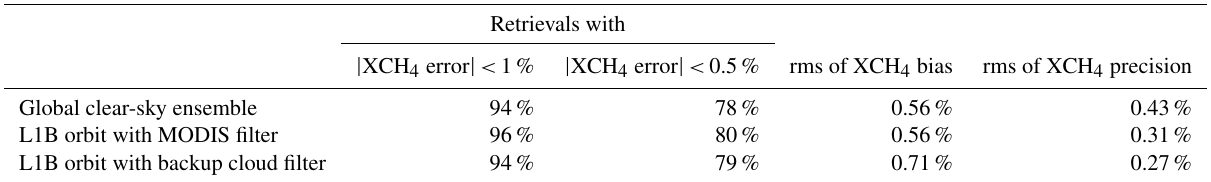
Figure 9. Simulations of a TROPOMI orbit. Panel (a) shows MODIS cloud fraction resampled on the orbit’s ground pixels. Panel (b) gives the XCH 4 bias of all processed pixels that converged. Panel (c) and (d) give XCH 4 bias of the valid retrievals after cloud filtering with MODIS data and the backup cloud filter, respectively. Here, we also applied the a posteriori filter based on retrieved scattering parameters and albedo. Table 3. Error statistics of XCH 4 retrievals from the L1B orbit using different cloud filters in comparison to the global clear-sky orbit. The performance of the MODIS filter is expected to be comparable with the operational cloud filter using VIIRS